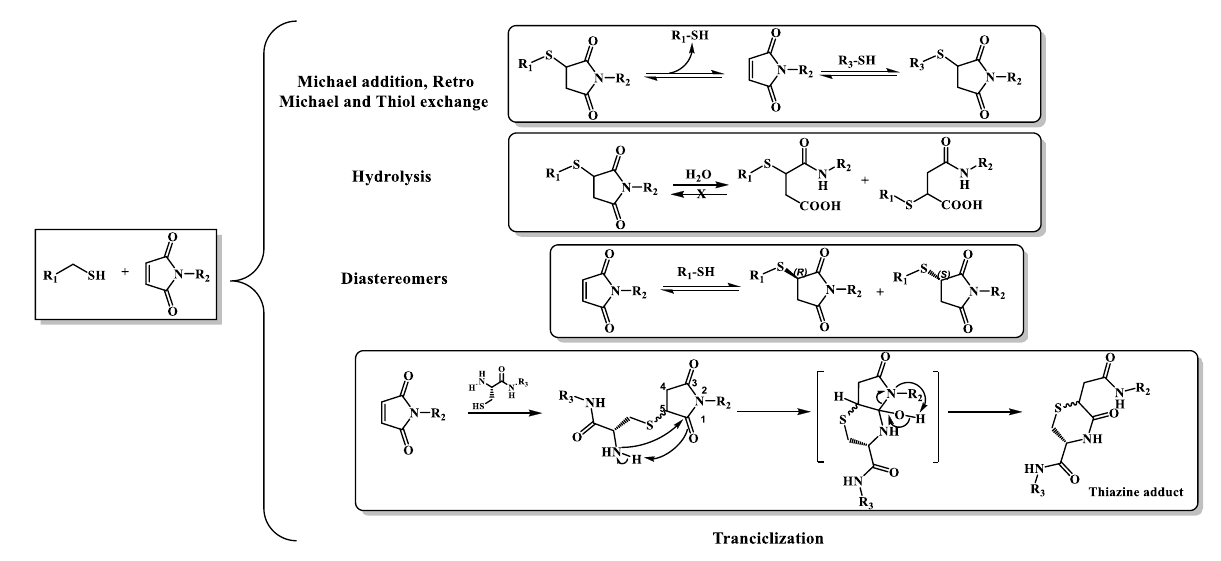
Figure 1. Michael thiol-maleimide addition reaction, rearrangements and products formed.